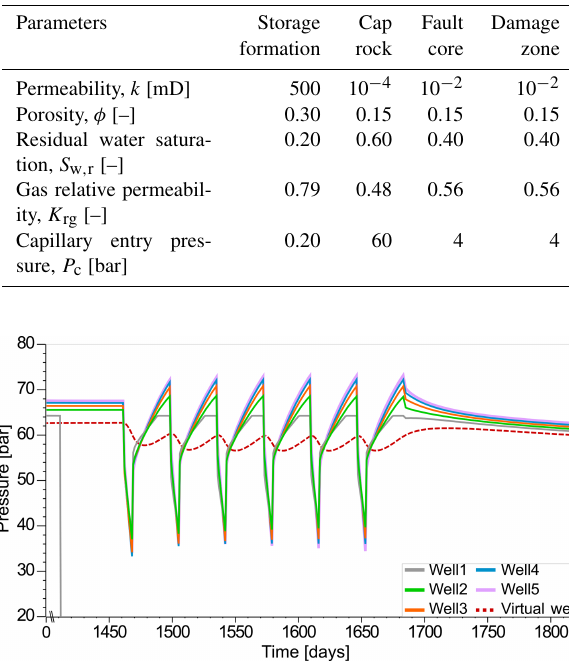
Figure 3. Bottom hole pressure for five vertical wells during the storage cyclic operation starting at day 1461 and the following shut- in period of 222d; the dashed red line depicts the pressure change at the position of the 2-D-slice used for the leakage scenario simu-